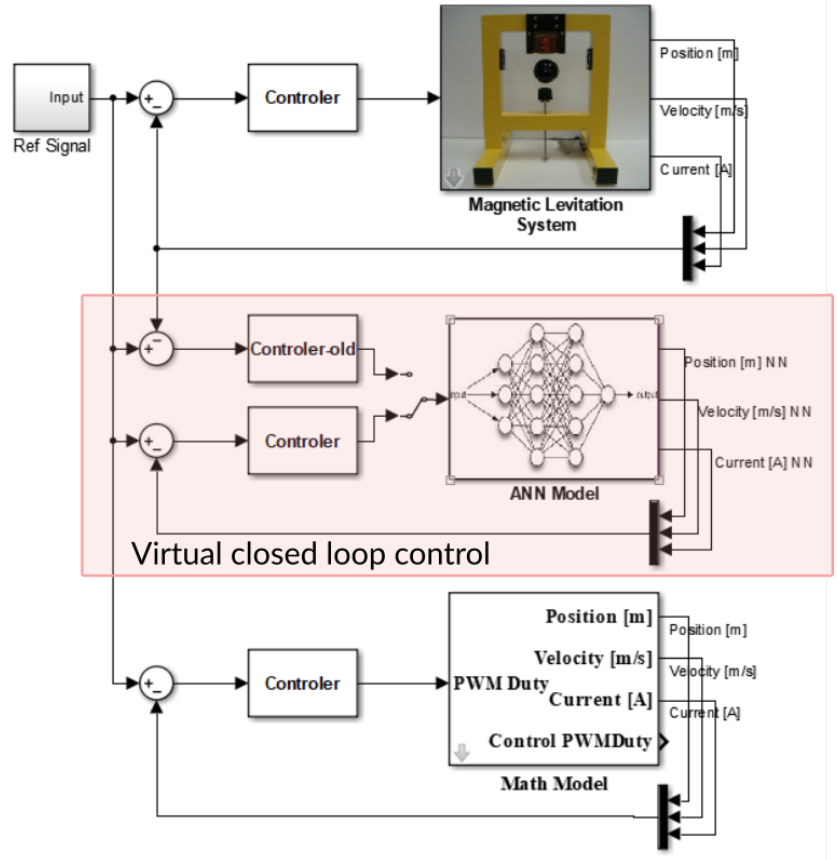
Figure 6. Overview of three parts, hardware, ANN model and Mathematical model.